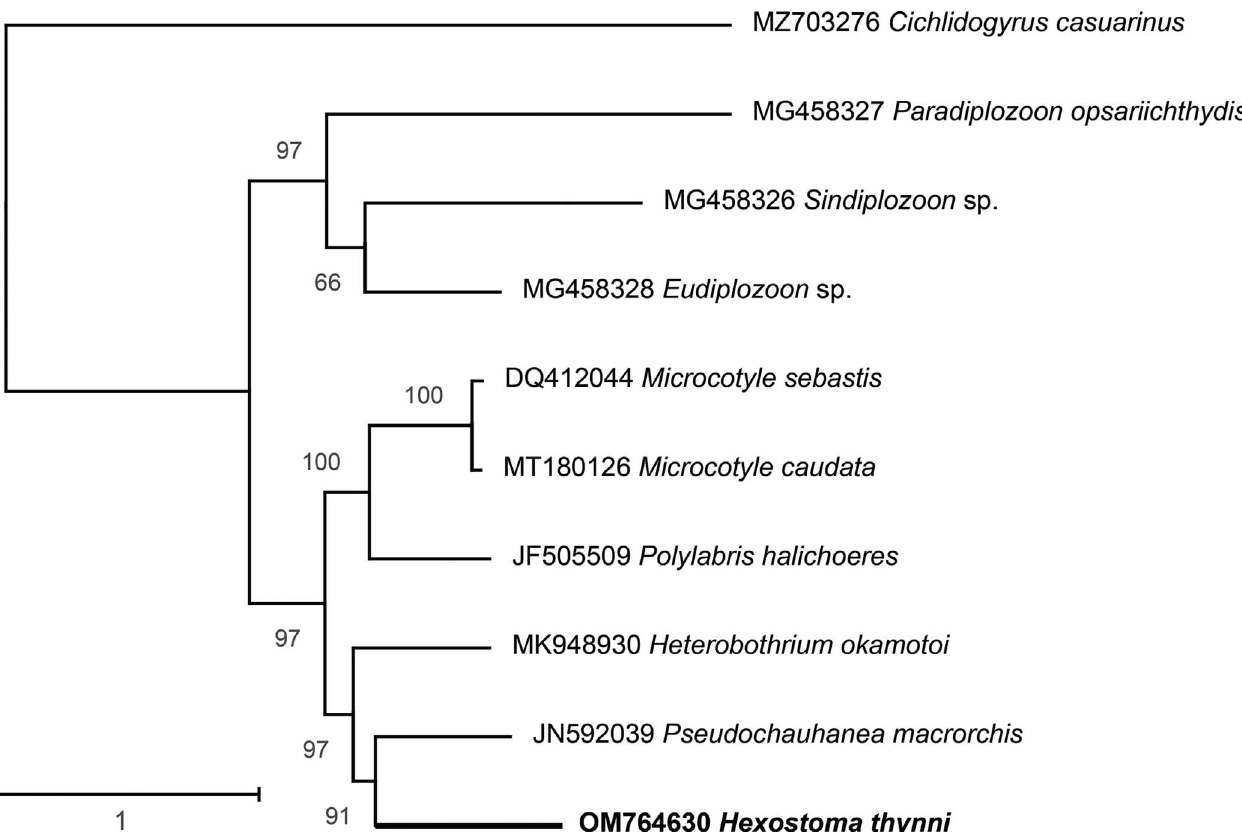
Figure 5. Phylogenetic tree based on protein-coding genes sequences of nine species of Polyopisthocotylea, with the Monopisthocotylea Cichlidogyrus casuarinus as outgroup. The tree has two large clades. The fi rst one contains only the Diplozoidae. The second includes members of the Mazocraeidea and is subdivided into two smaller subclades, with one containing the Microcotylidae and the other containing the Chauhaneidae, Diclidophoridae and Hexostomatidae ( H. thynni ). Hexostoma thynni is not the sister-group to the other